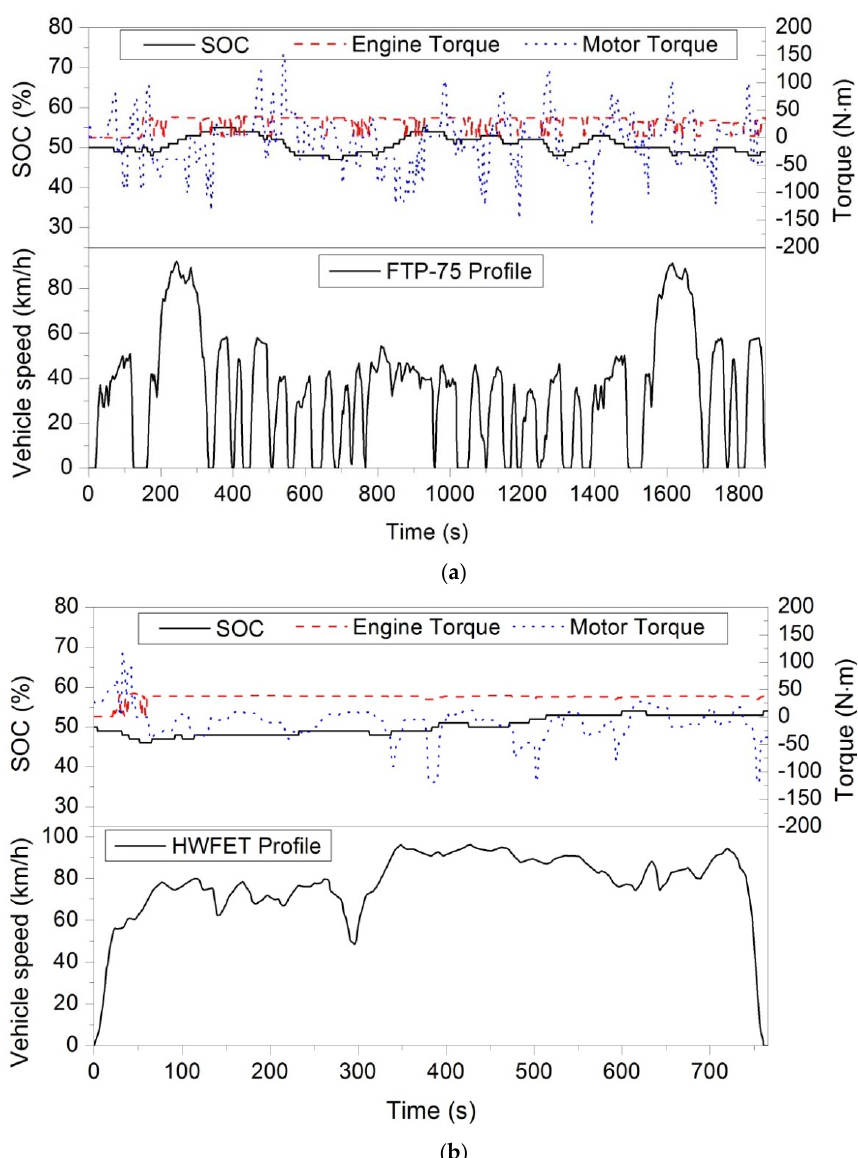
Figure 8. Characteristic of power distribution with driving: ( a ) FTP ‐ 75; ( b ) HWFET.